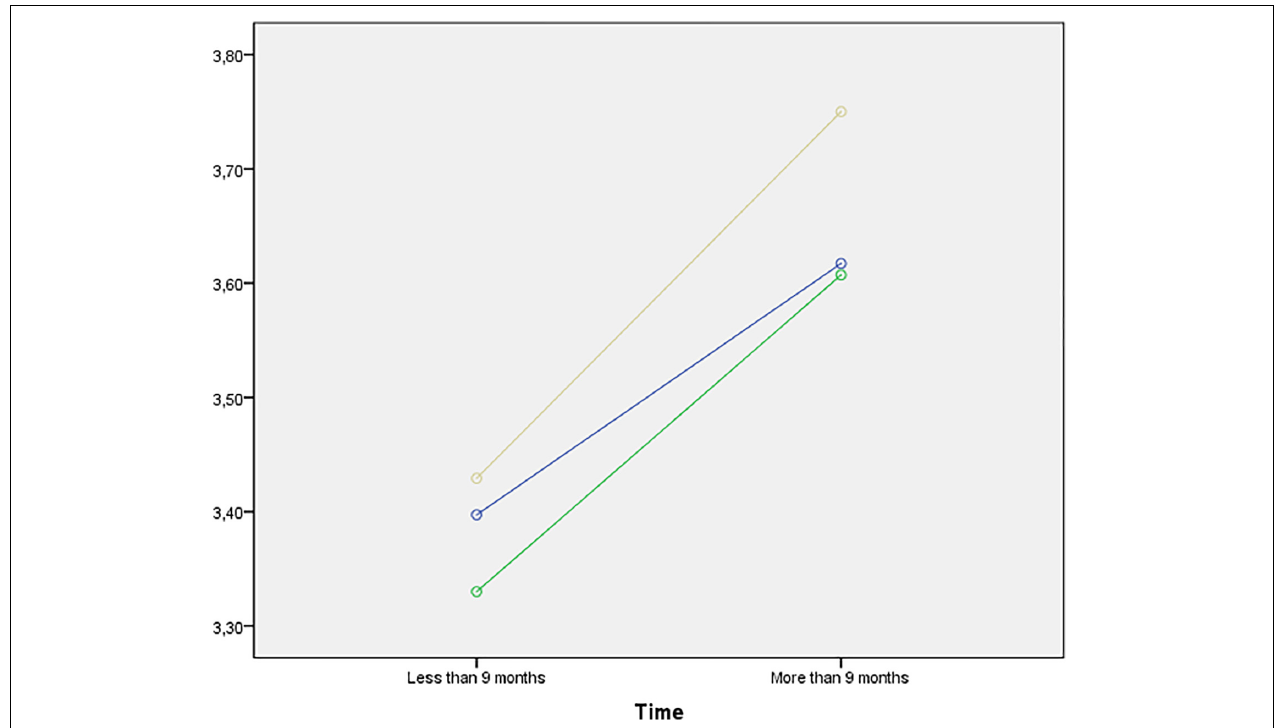
FIGURE 3 | Mean values of Understanding (factor 3) by educational level and time of residence. Note: Blue (Primary Education; Green (Secondary Education); Yellow (Baccalaureate—Vocational